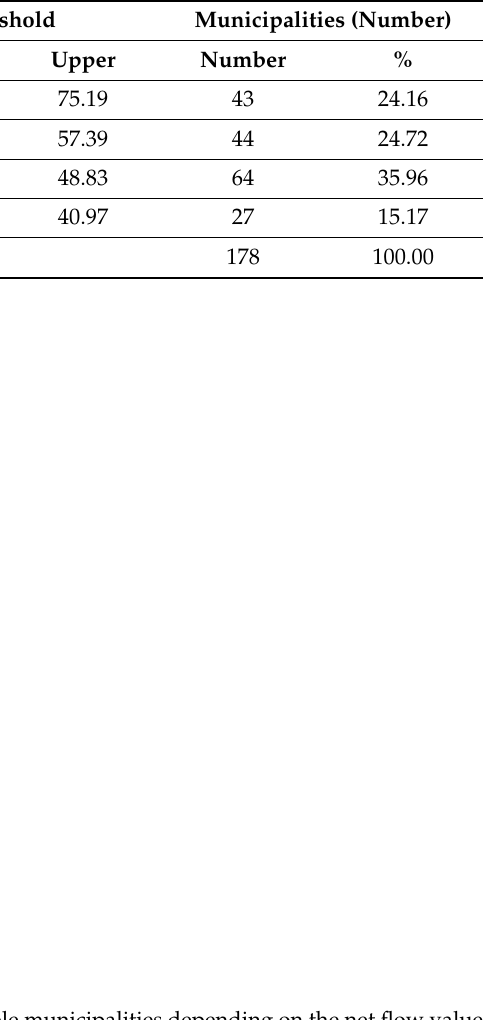
Figure 11. Map of the outranked areas in the suitable municipalities depending on the net flow value (the higher the score is the better the municipality).